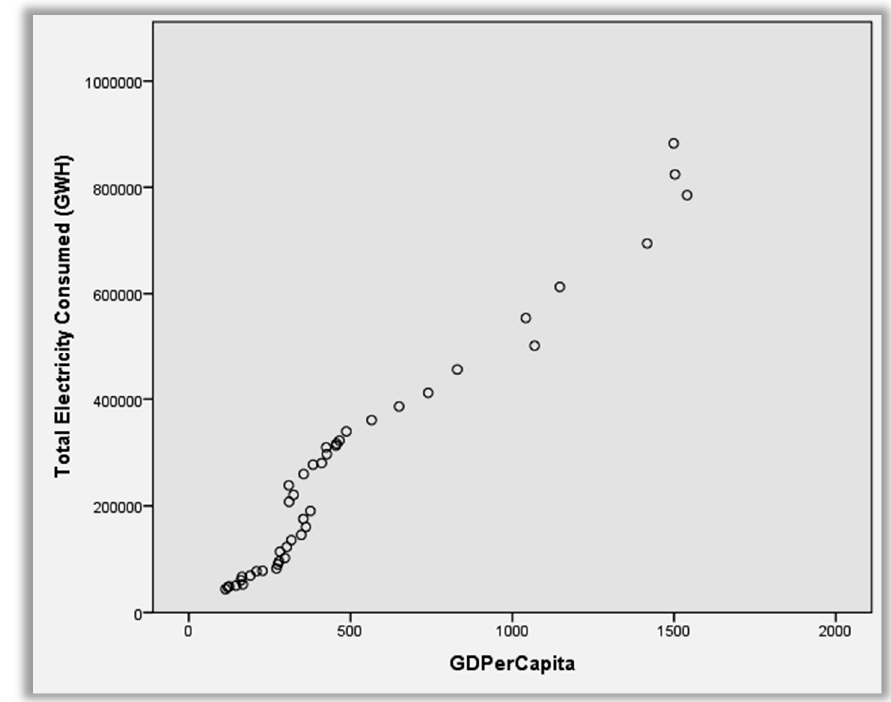
Figure 8. Plot between GDP per Capita and TEC.